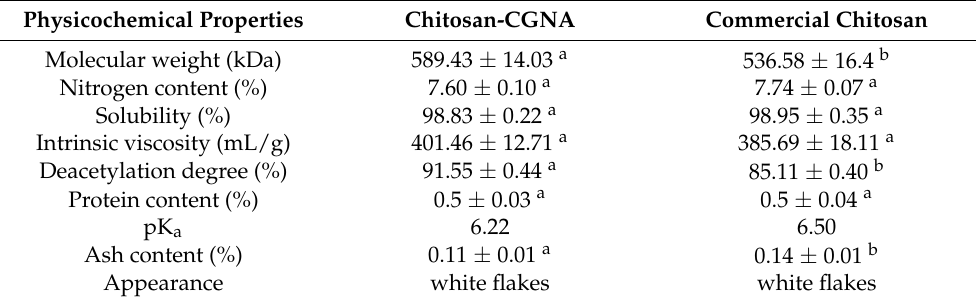
Table 1. Physicochemical characterization of chitosan samples. Physicochemical